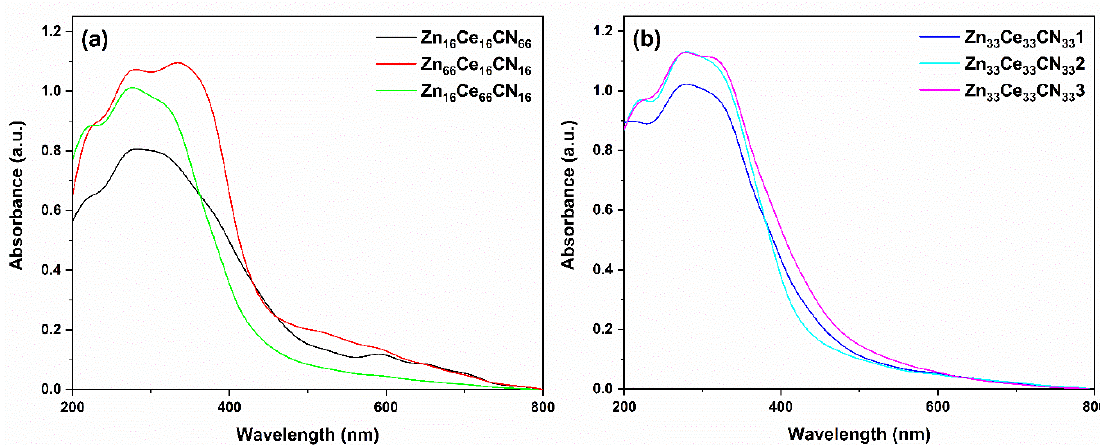
Figure 6. Absorption spectra of the ( a ) ternary and ( b ) replicate samples.